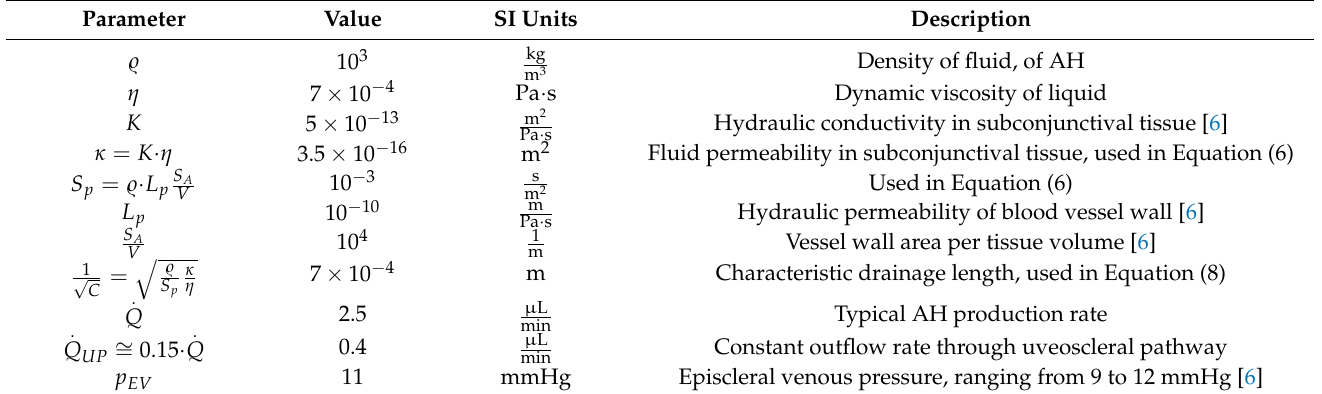
Table A2. Governing parameters for